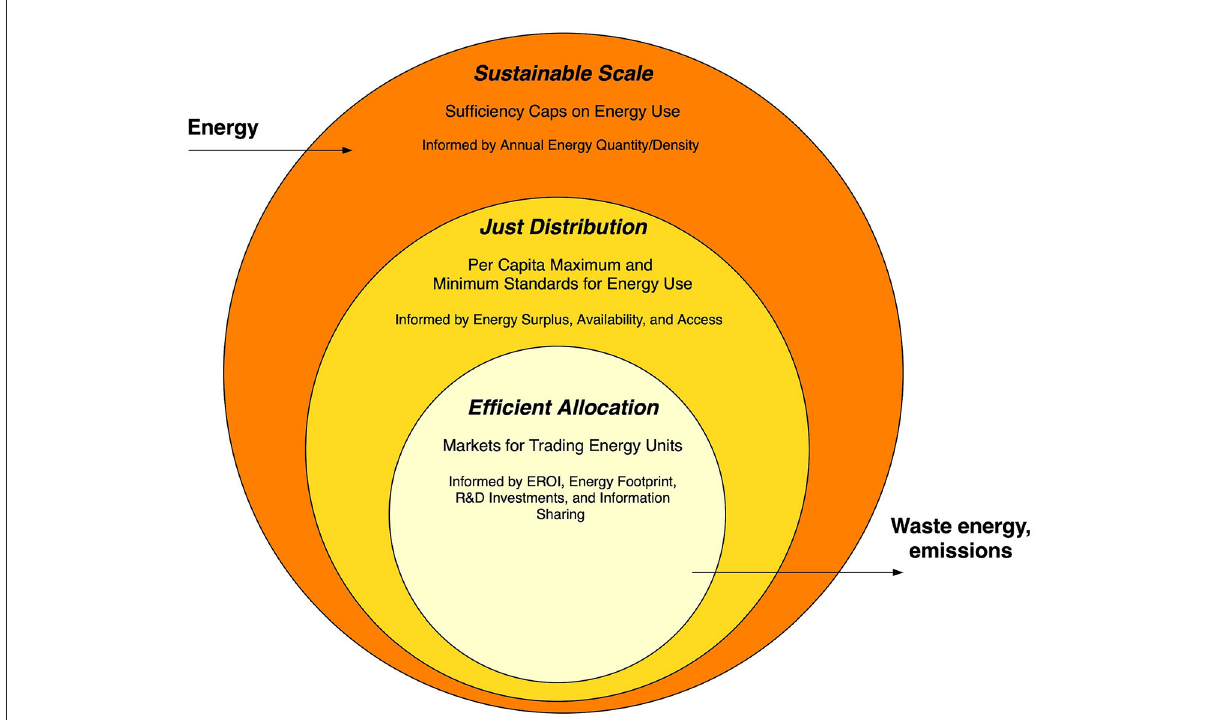
FIGURE2 Energy sufficiency as characterized by three goals of ecological economic development: sustainable scale, just distribution, and efficient allocation of energy